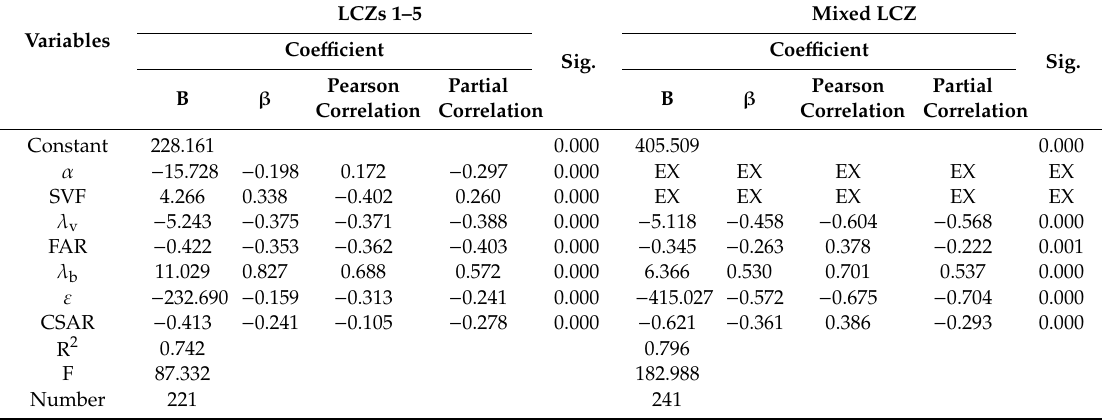
B = unstandardized coe ffi cient. β = standardized coe ffi cient, Sig. = Significant level, EX = regression model excluded the